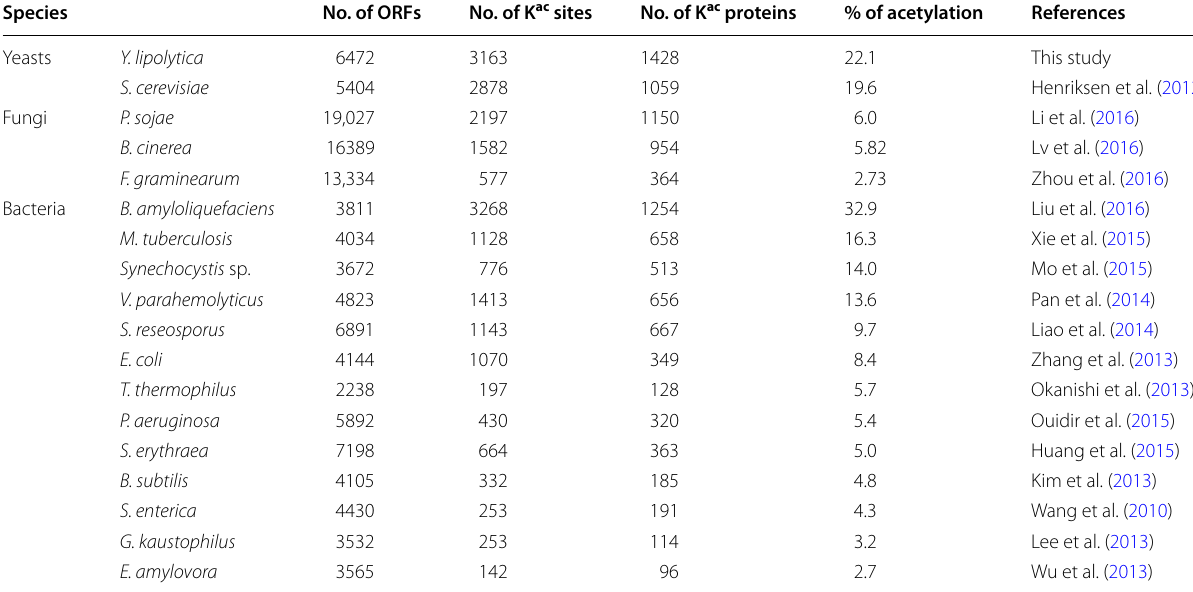
Table 1 Comparison of Y. lipolytica acetylome with those of other published microorganisms Species No. of ORFs No. of K ac sites No. of K ac